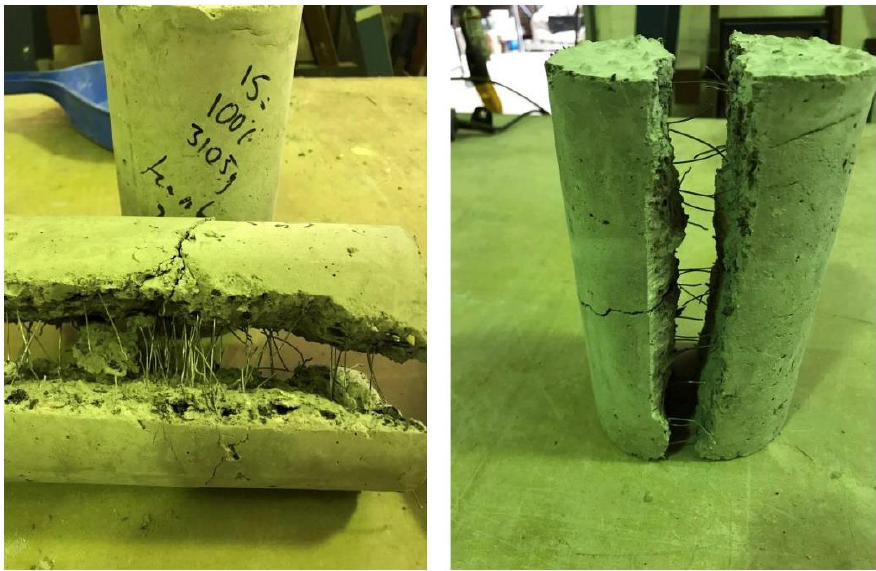
Figure 16. Fiber reinforcing effect in recycled concrete tested for residual splitting capacity. Copyright permission is taken from [51].